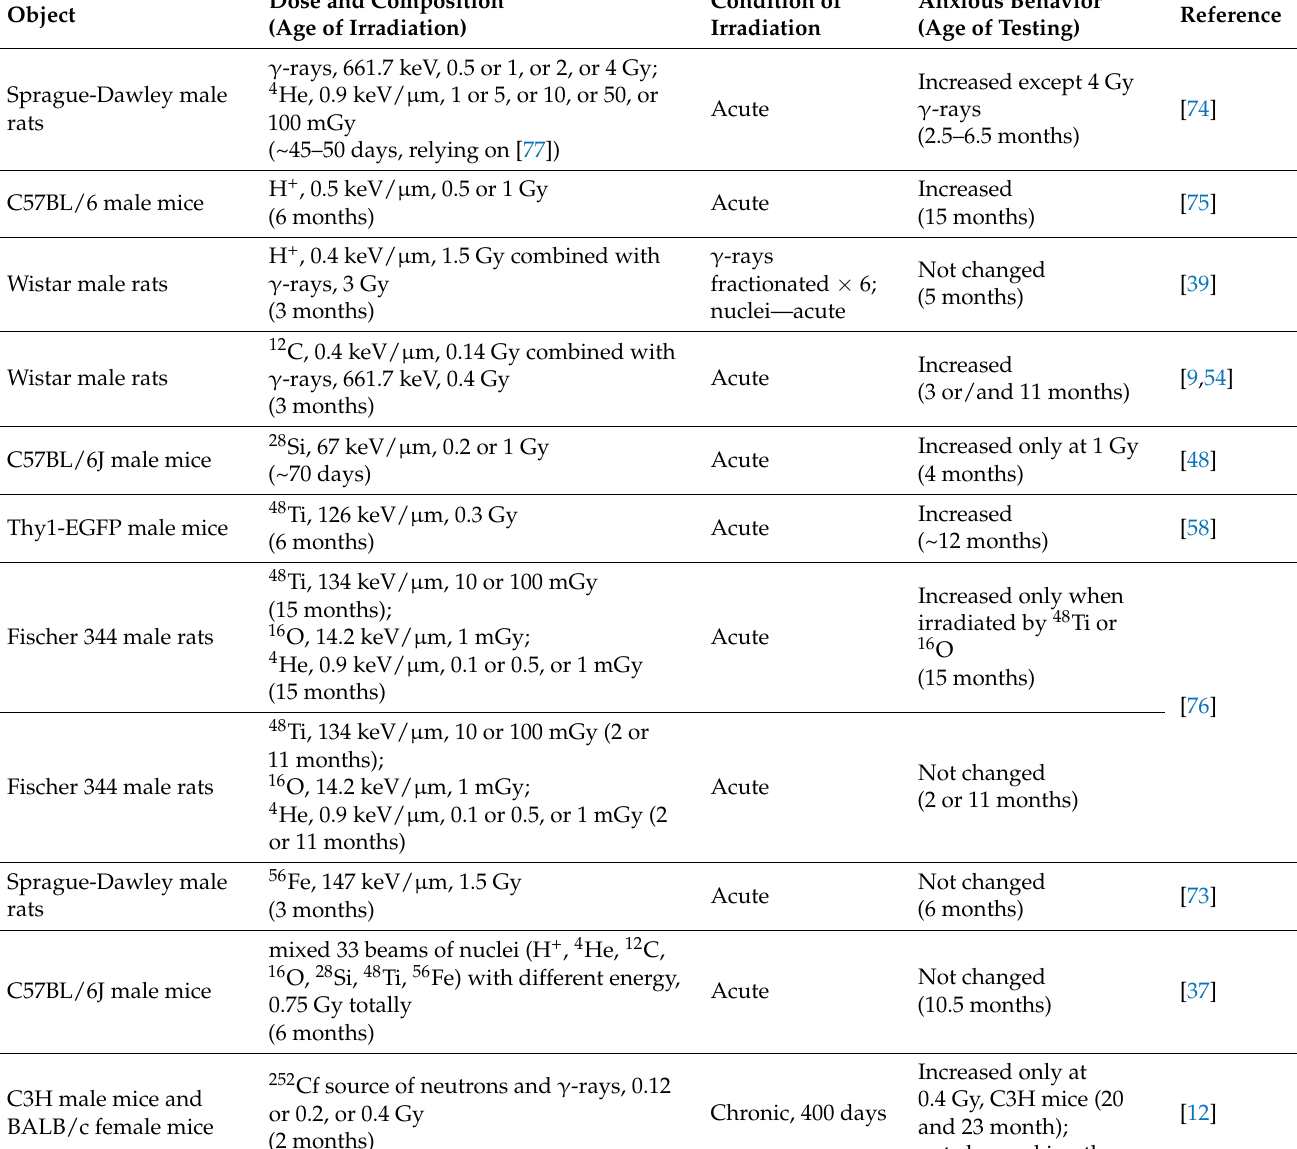
Table 1. Anxiety and ionizing